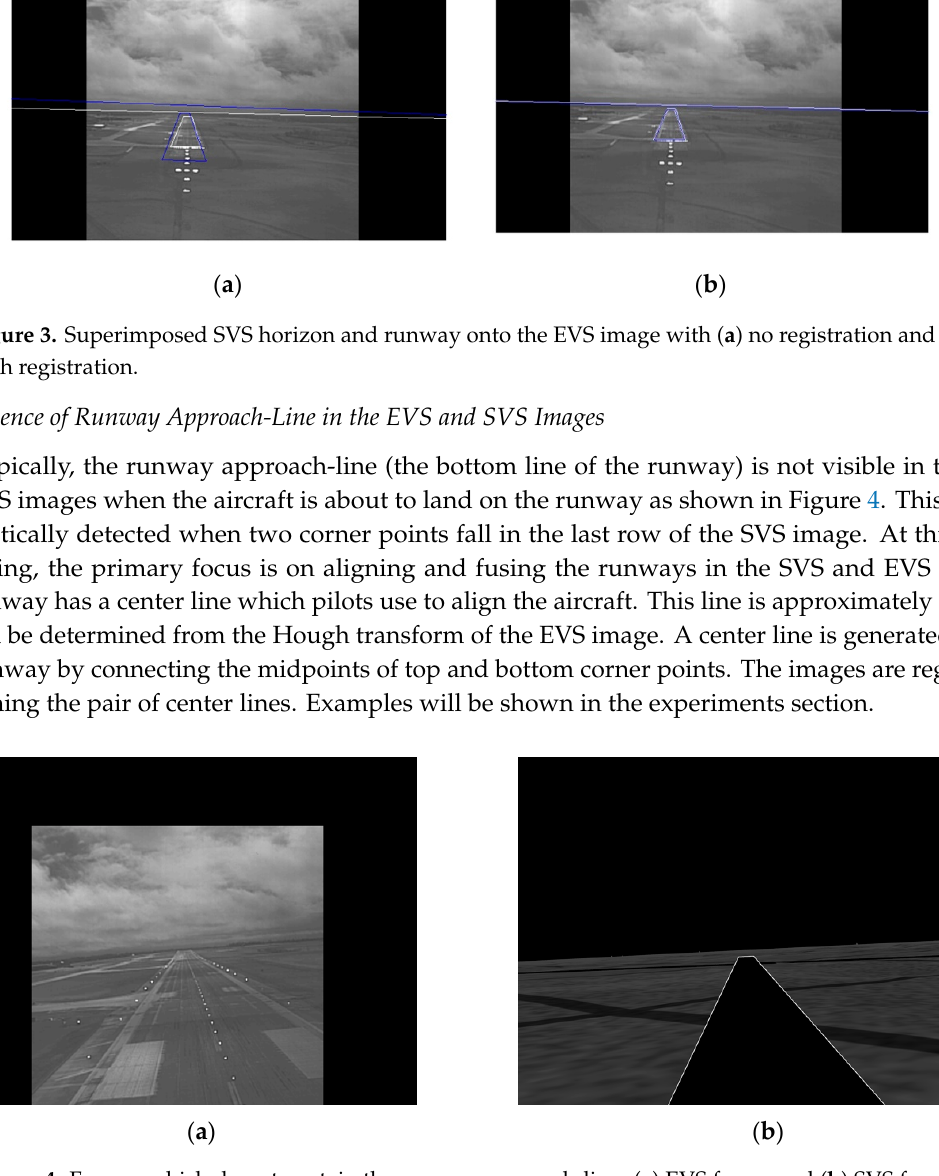
Figure 4. Frames which do not contain the runway approach-line: ( a ) EVS frame and ( b ) SVS frame.